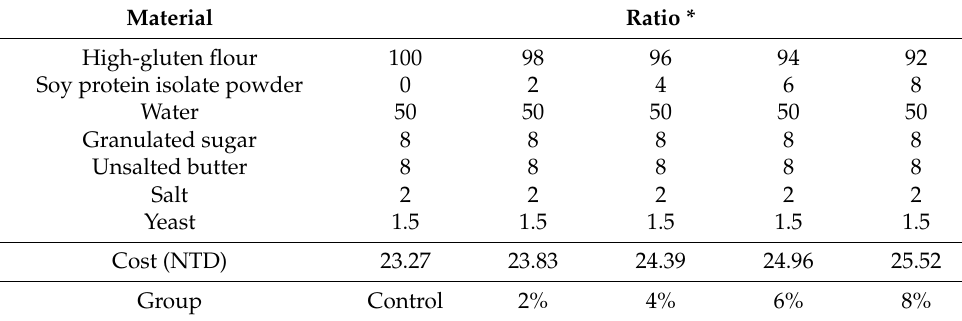
Table 1. Recipes and costs of the breads in this